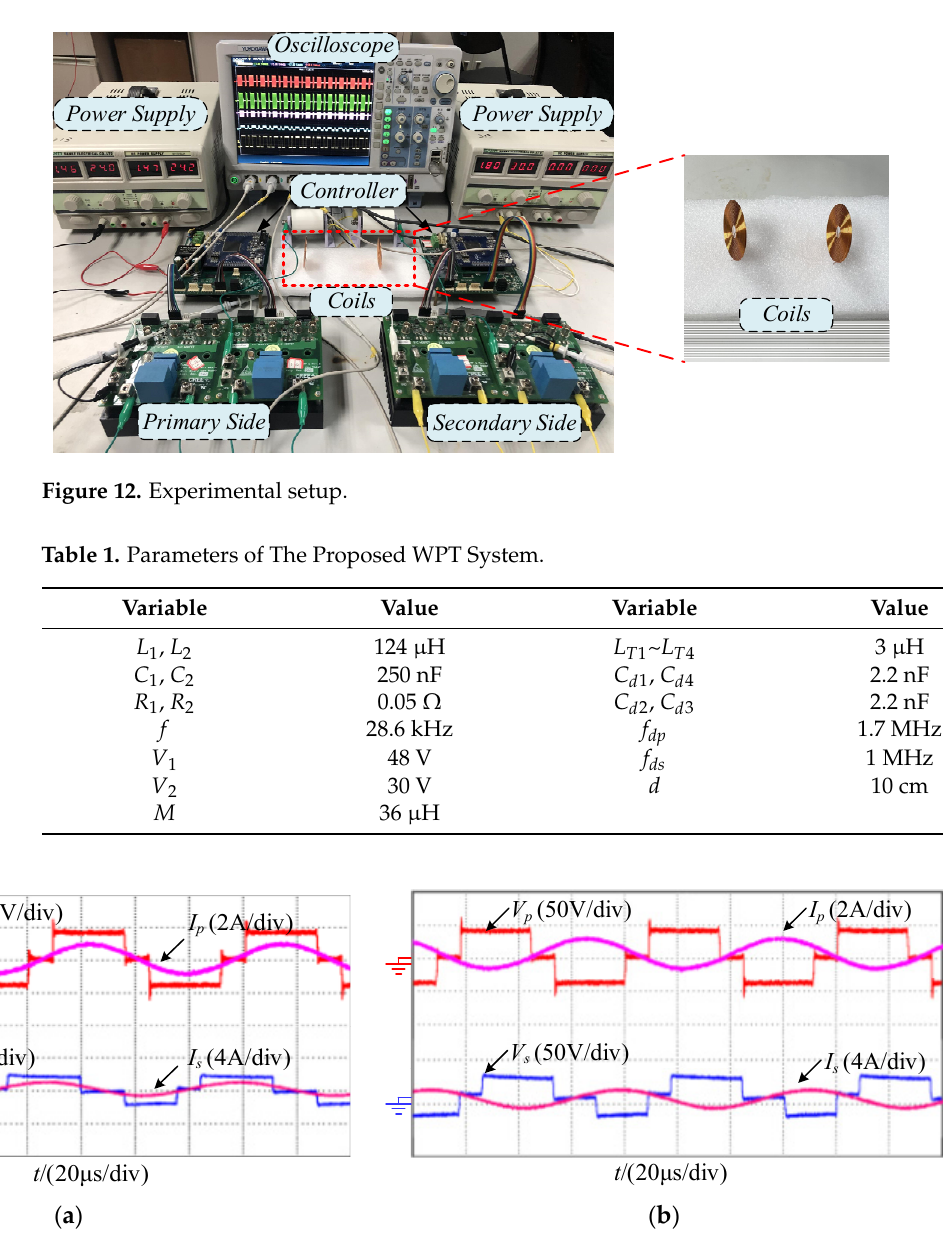
Figure 13. Measured voltage and current waveforms of the primary and the secondary side during bidirectional power transfer. ( a ) Forward power transfer. ( b ) Backward power transfer.